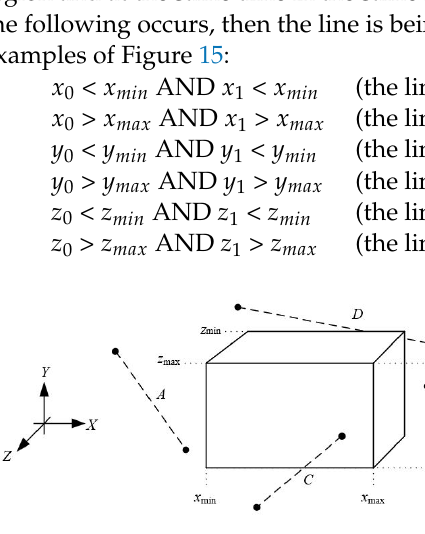
Figure 15. Rejected lines: line A is left of the clipping region, line B is right of the clipping region, line C is in front of the clipping region, and line D is on the back of the clipping